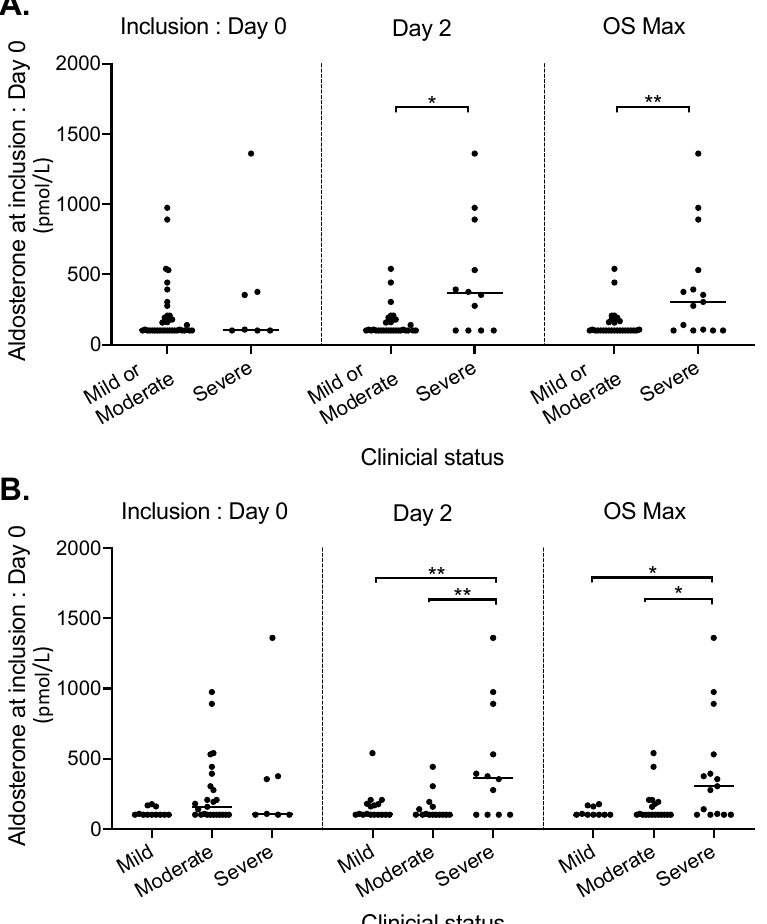
Figure 2. Plasma aldosterone levels at inclusion according to clinical status of patients with Covid-19 infection at Day 0, Day 2 and at the maximum ordinal scale (OS) during the overall period of hospitalization (OS max). The median values are shown (crossbar), in two ( A ) or three ( B ) groups related to clinical status severity: mild (OS ≤ 3, n = 10), moderate (OS = 4, n = 10) and severe (OS ≥ 5, n = 15). ** p < 0.01; * p < 0.05 (Mann–Whitney test).